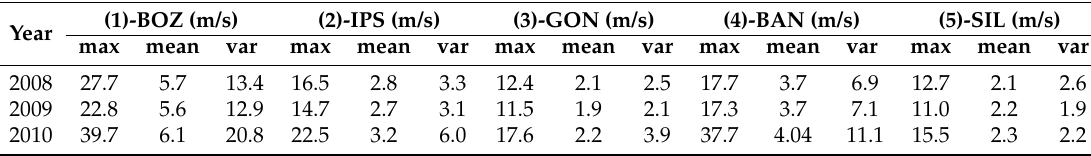
Table 1. Some basic statistics of the used multi-channel data